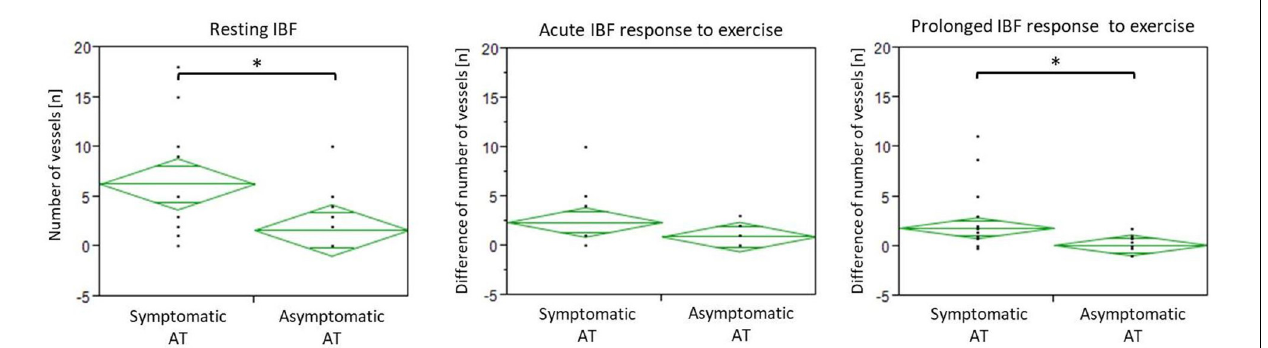
FIGURE 4 | Diamond plots showing mean and 95% CI of IBF at baseline (resting IBF), difference between U5 and Upre (acute response), and mean difference between U30–120 and Upre (prolonged response). ∗ Indicates significant intraindividual differences ( p < 0.01).